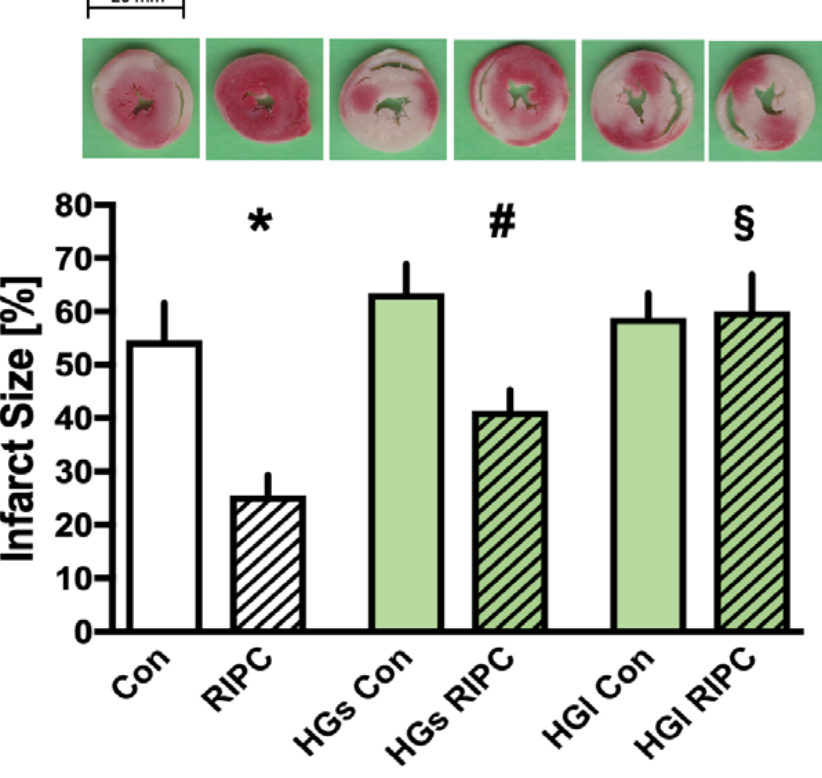
Figure 1. Infarct size measurement. Histogram shows all infarct sizes of the study. Data are presented as means ± SD, * p < 0.05 vs. Con, # p < 0.05 vs. HGs Con, § p < 0.05 vs. RIPC.